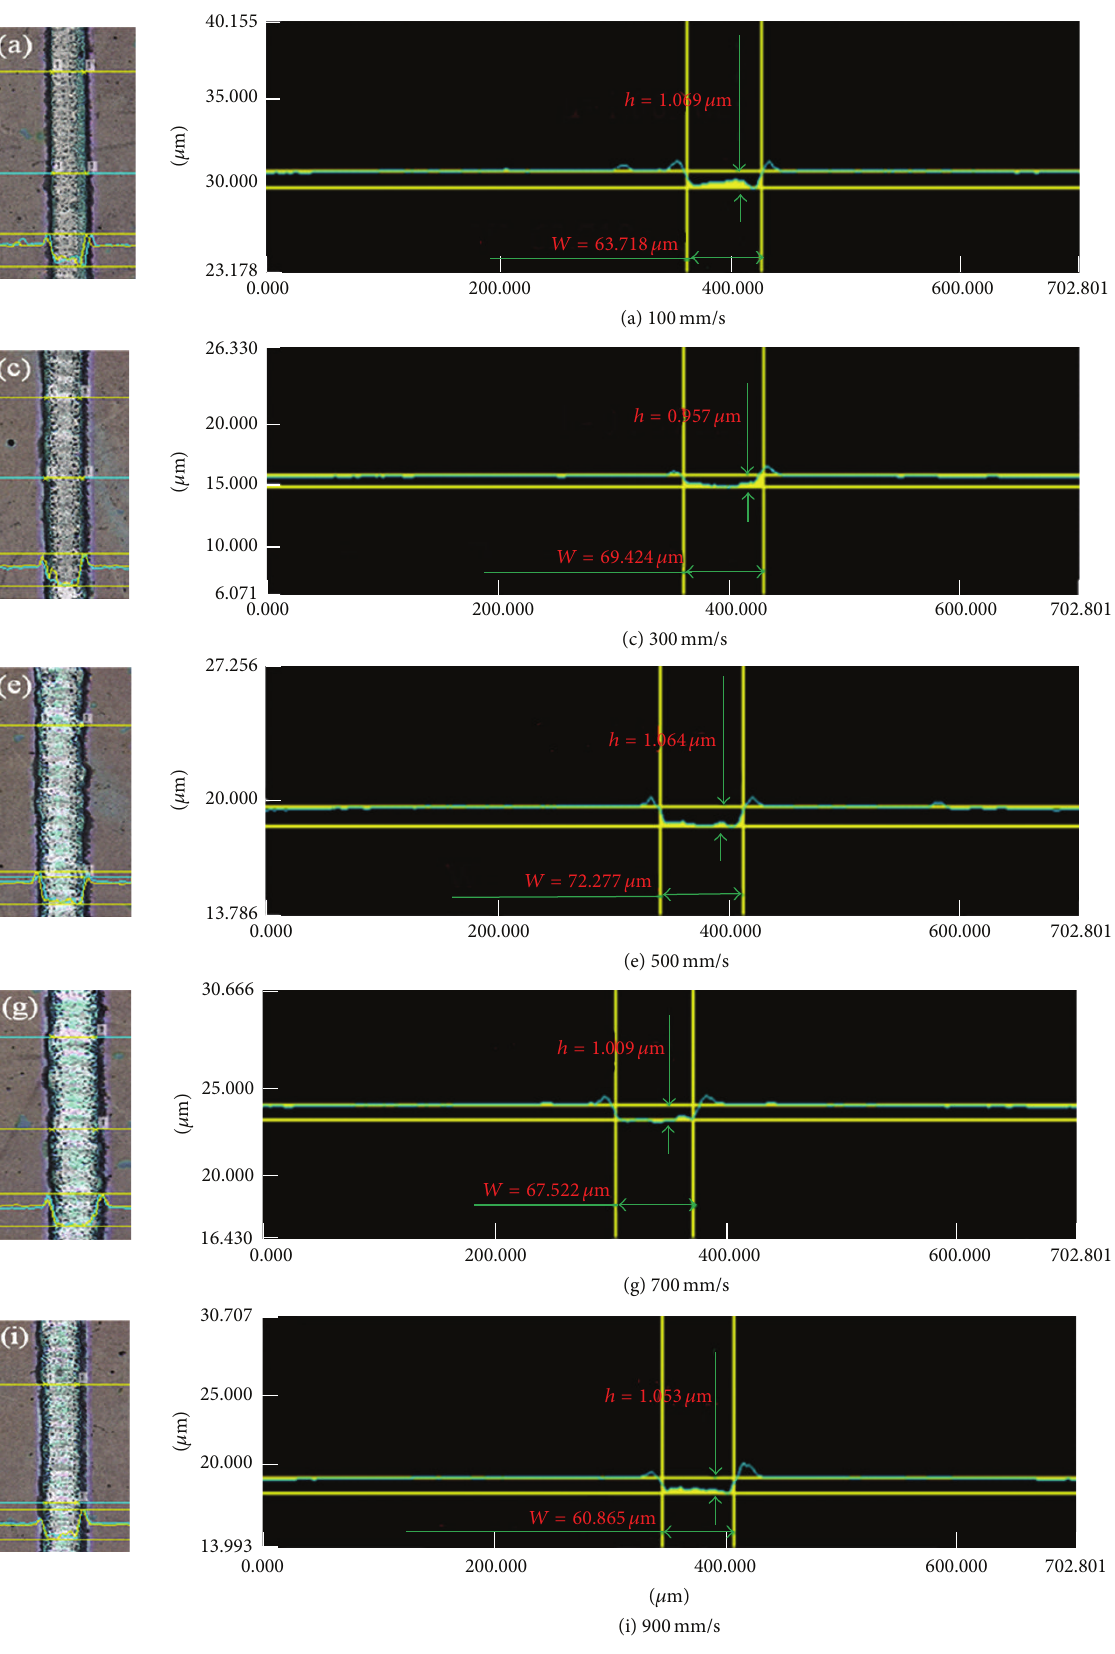
Figure 7: Illustration of UV lasers using different scanning velocities for scribing P2 film on 3D confocal